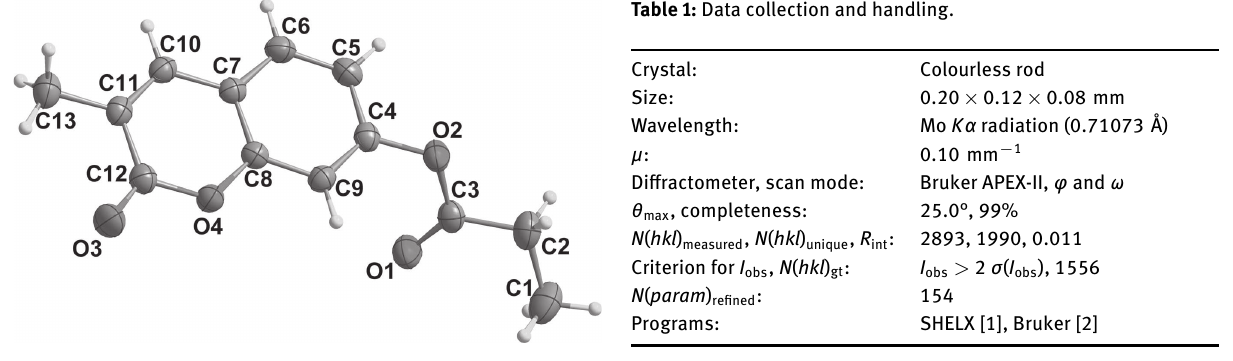
Table 1: Data collection and handling.